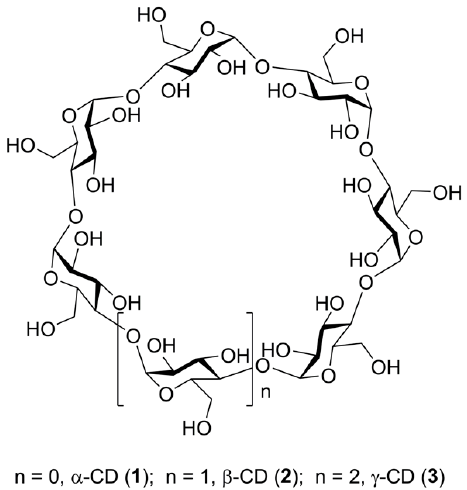
Figure 1. A general structural formula of α -, β -, and γ -cyclodextrins ( 1 – 3 ).